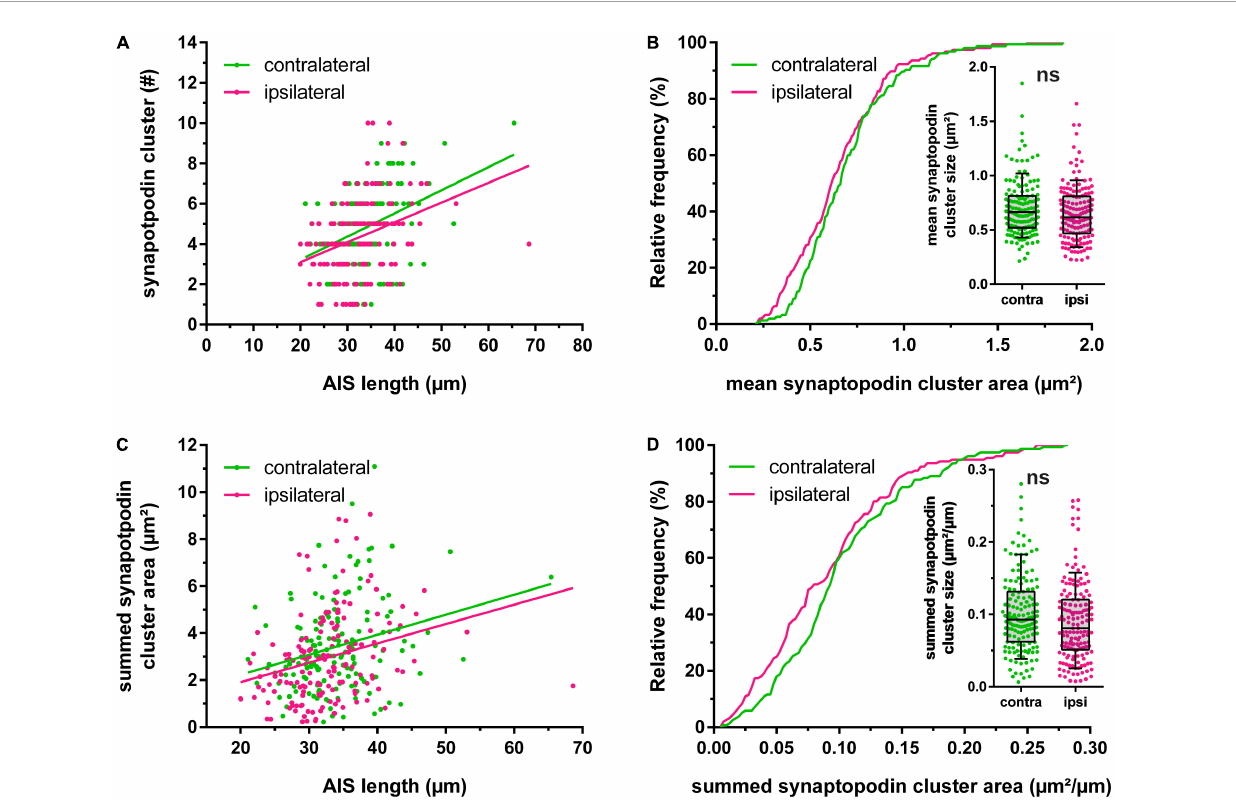
FIGURE2 Homeostatic adaptation of synaptopodin. (A) Relationship between length of the axon initial segment (AIS) and absolute number of synaptopodin clusters. (B) The mean area of synaptopodin clusters was not significantly altered following 2 h high frequency stimulation. (C,D) The summed area of synaptopodin clusters was normalized to the AIS length and showed no significant changes between stimulated vs. non-stimulated granule cells. Number of segments: (A–D) n contralateral = 155, n ipsilateral = 156. Box and whiskers represent 10–90 percentile. ns > 0.05, Mann–Whitney